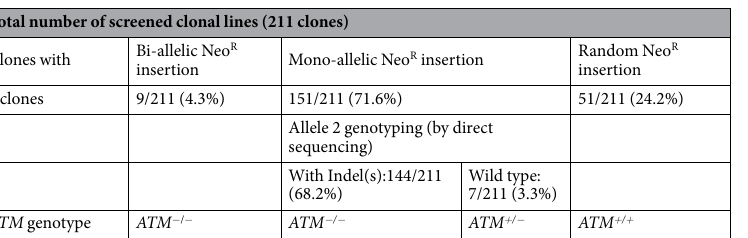
Table 2. Generation of ATM -edited hTERT-RPE1 cell clones using “CRISPR/ObLiGaRe” method. A total of 211 neomycin-resistant clones were isolated. Two-step genotyping analysis revealed that 153 (72.5%) and 7 (3.3%) clones were ATM − / − and ATM + / − ,